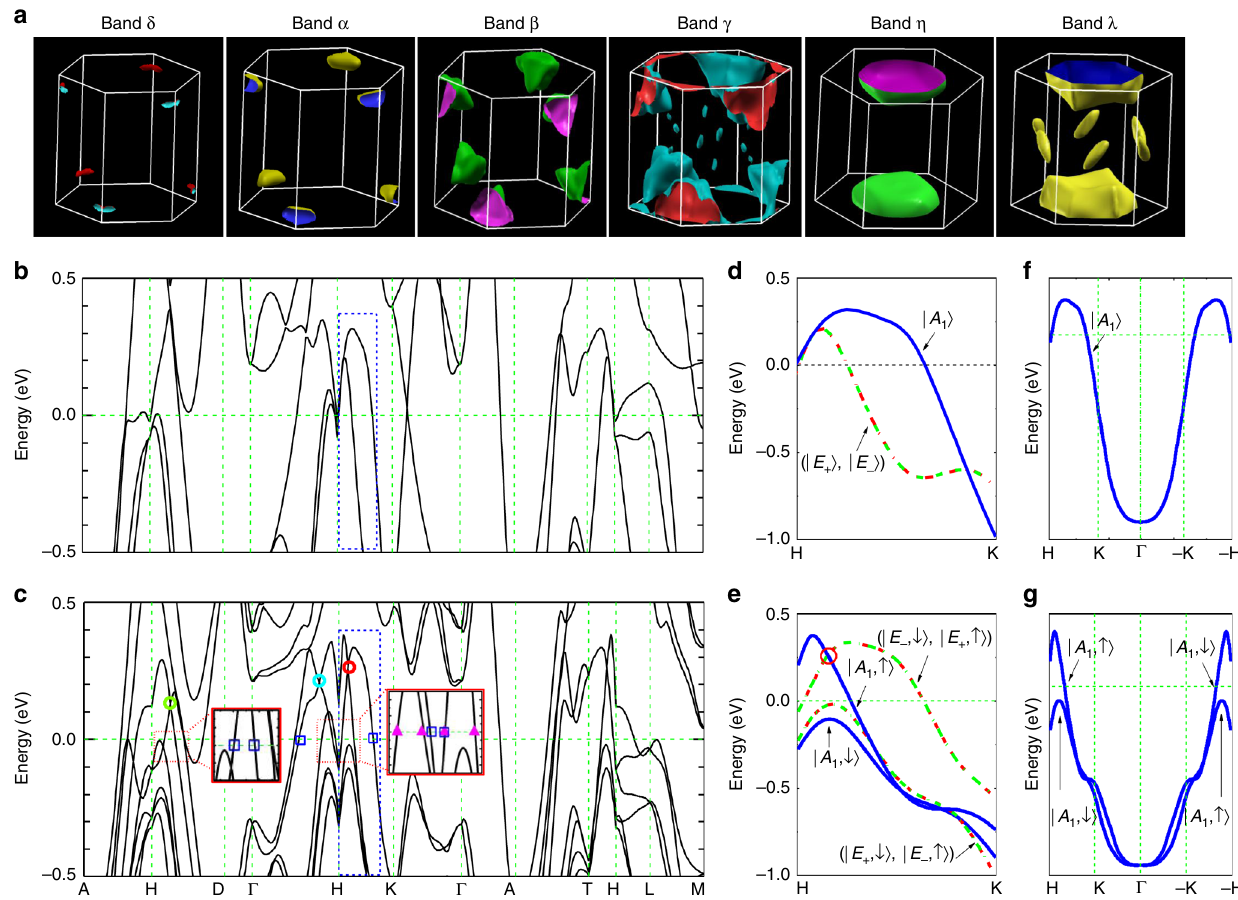
Fig. 5 3D Fermi surface pockets and band structures. a Fermi surface pockets from ab initio calculations. Band structure along the direction of high- symmetry lines in the BZ ( b ) without and ( c ) spin – orbit coupling. Red circle along the H – K line labels the TP. The light blue circle along the H – Г line and the green circle along the H – D line labels the doubly degenerate points. Inset: Enlargement of the red rectangular boxes. The pink solid triangles ( ▲ ) and blue open squares ( □ ) indicate the high-symmetry lines penetrating through the α and β pockets, respectively. d and e are magni fi ed views of the blue-dashed rectangles in b and c , respectively. Bands are indicated by the relevant irreducible representations. f Spinless band along the H – K – Г – ( − K) – ( − H) line. g |A 1 〉 state split into two different substates by taking into account the spin degree of freedom due to the breaking of spatial inversion